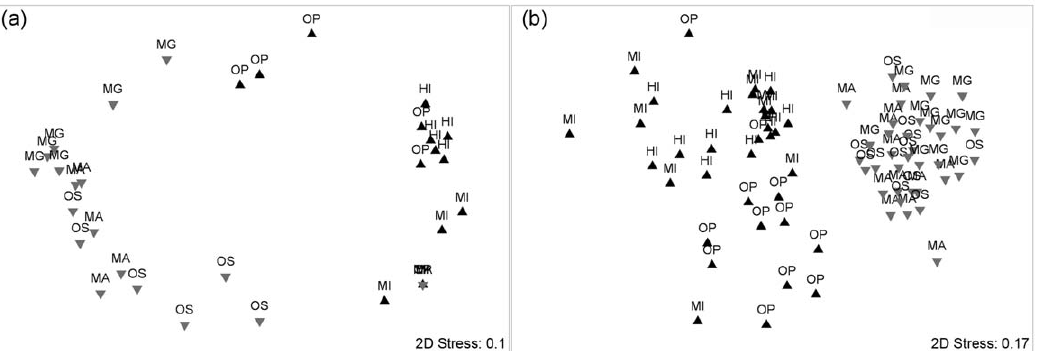
Figure 3. Non metric multidimensional scaling plots (nMDS) comparing: (a) the herbivorous fish assemblages feeding on the algal bioassays between regions (symbols) and locations (n=6), and (b) the herbivorous fish assemblages surveyed using underwater visual census between regions (symbols) and locations (n=6). All data were fourth-root transformed prior to ordination. Locations have been abbreviated as follows: HI=Halfway Island, MI=Middle Island, OP=Olive Point; MG=Mangrove Bay, MA=Mandu,